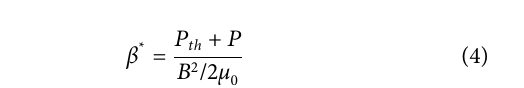
Frontiers in Astronomy and Space Sciences |